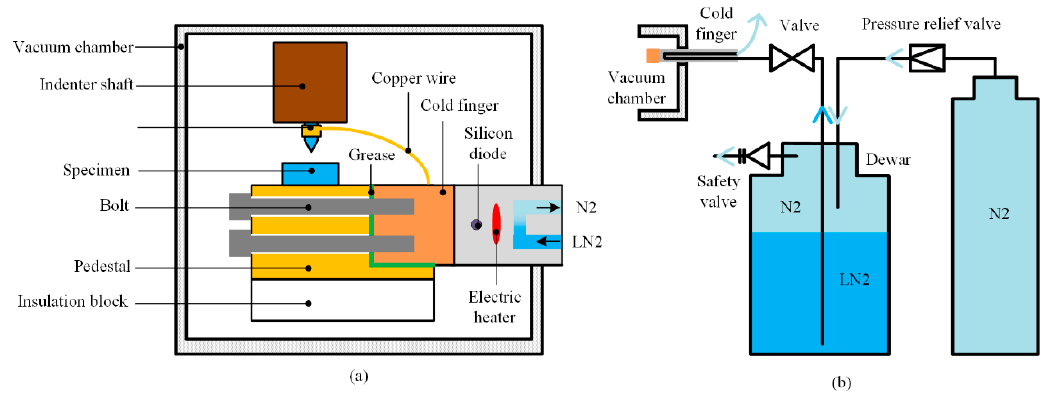
Figure 10. Schematic diagram of DSI apparatus with cold finger ( a ) indentation setups inside vacuum chamber ( b ) cooling system